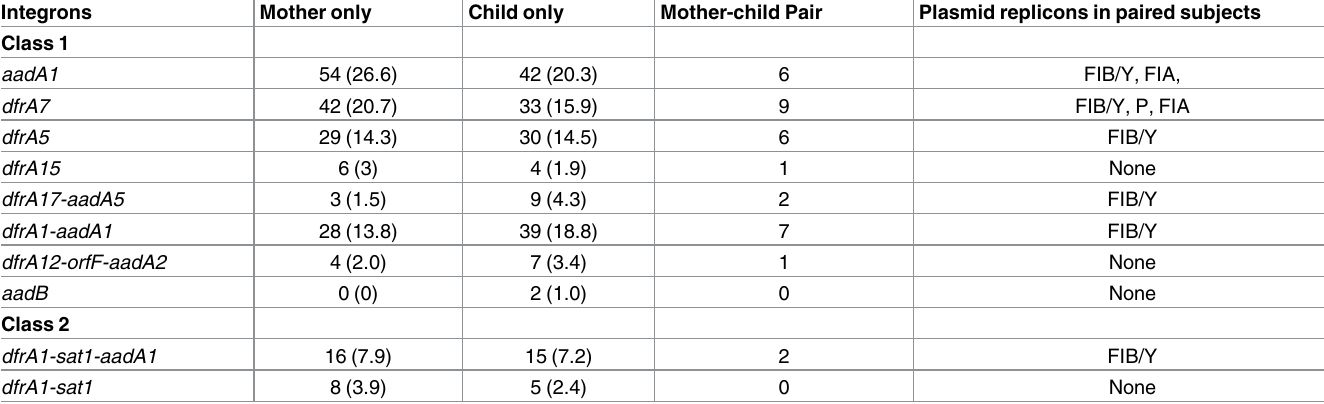
Table 4. Integrons associated with plasmid replicon types in mother and child pairs isolates.